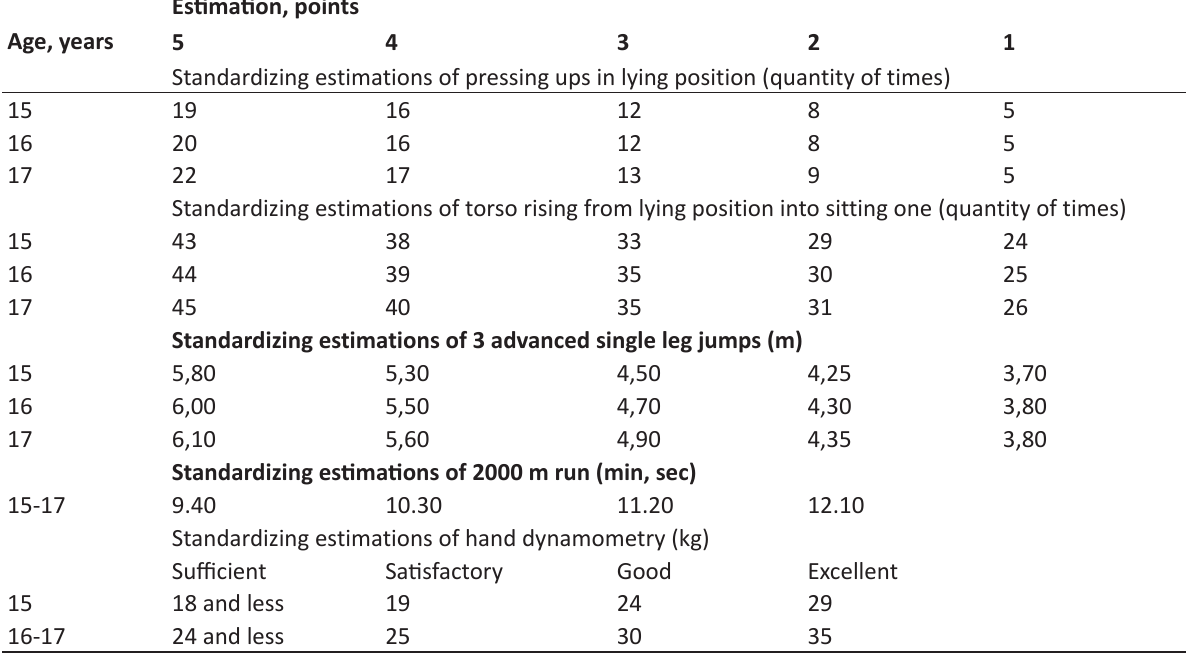
Table 1 . Standardizing estimations